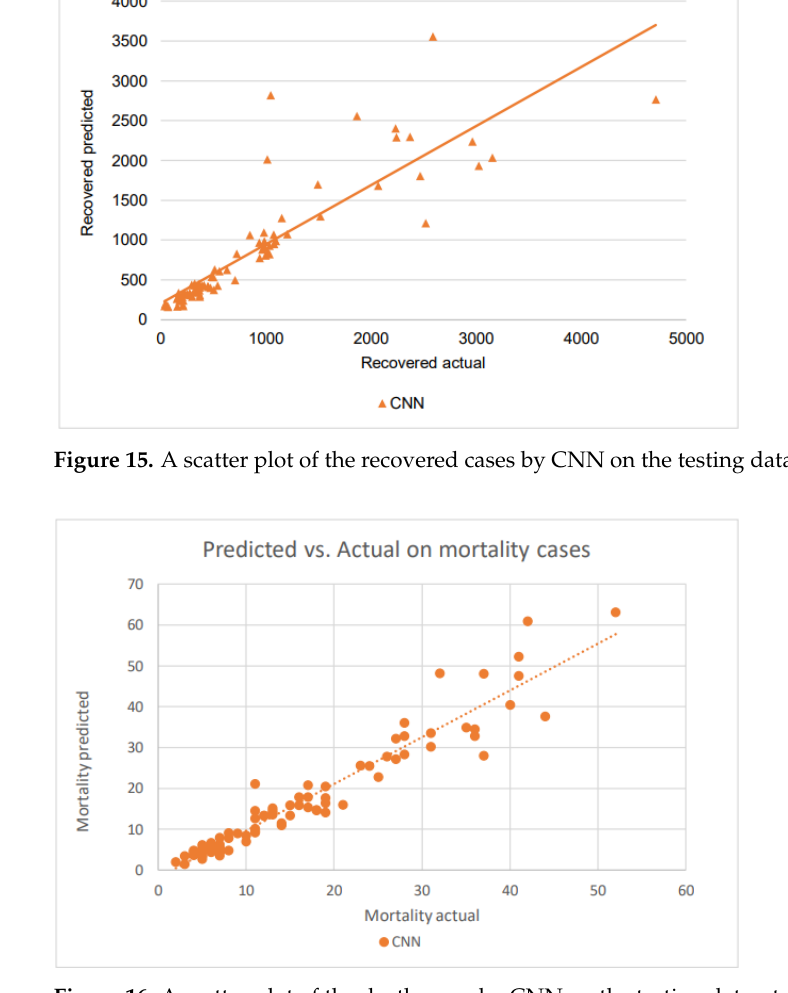
Figure 16. A scatter plot of the death cases by CNN on the testing